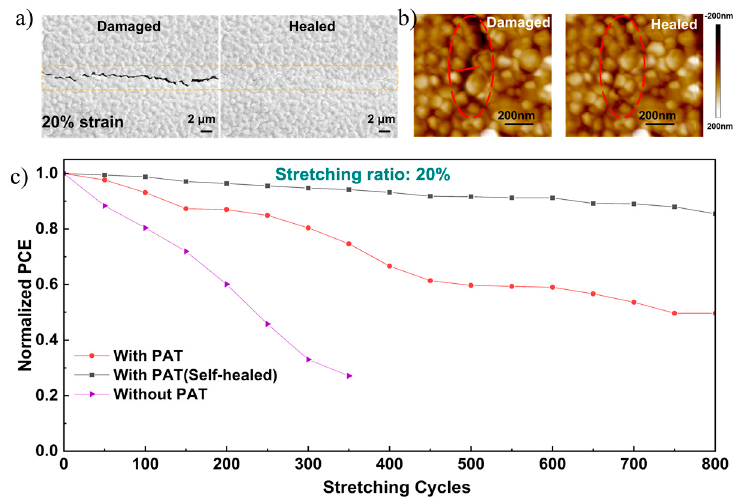
Figure 5. ( a ) SEM and ( b ) AFM images of damaged and healed perovskite films. ( c ) SPSC’s normal- ized average PCE as a function of stretching cycles with 20% strain.